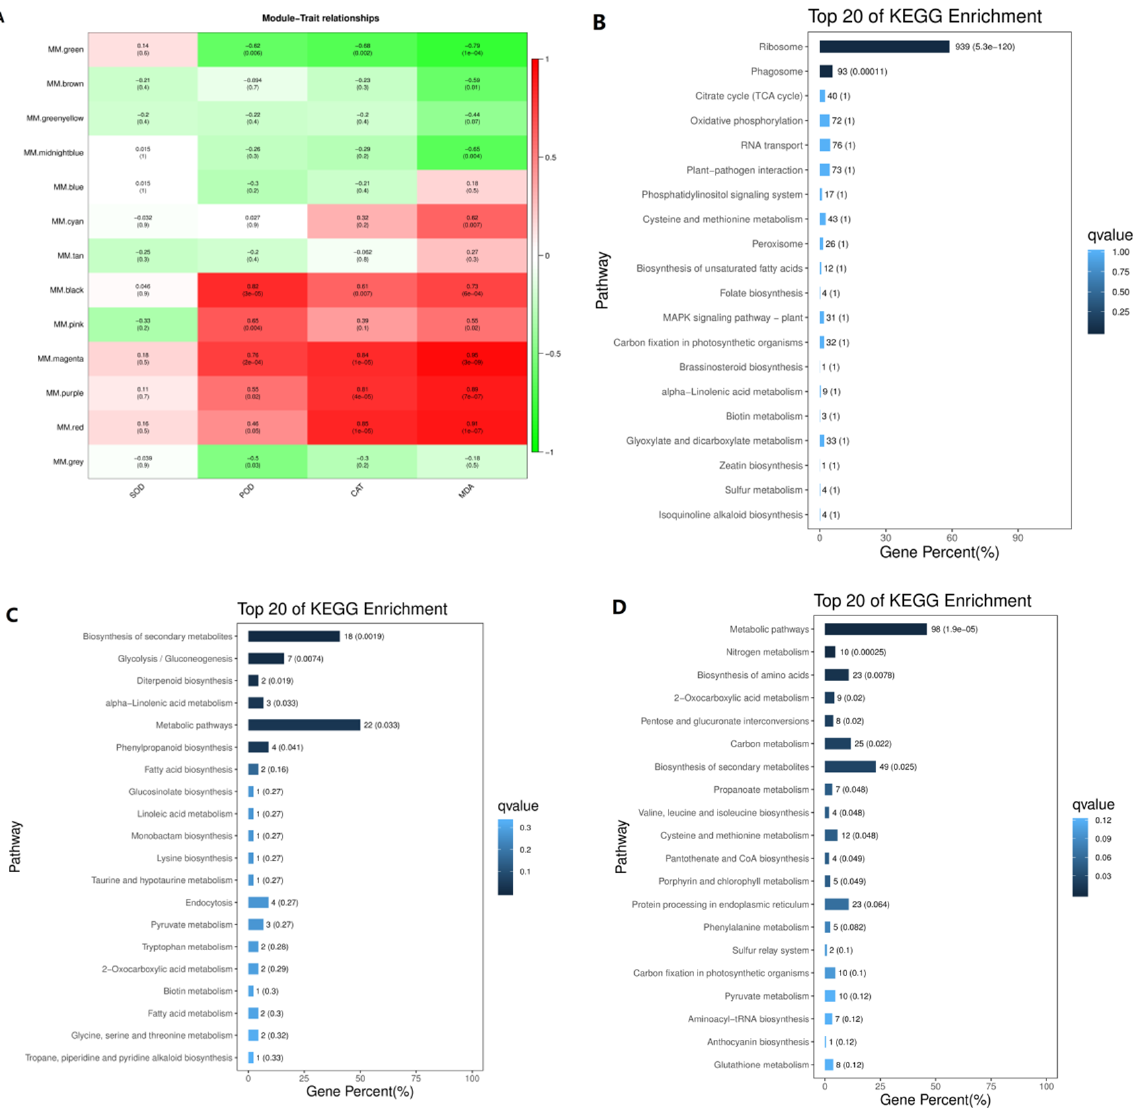
Figure 6. Co-expression network and KEGG enrichment pathways in goldenrain tree under cadmium stress. ( A ) Module- trait association. In the correlation matrix, each row corresponds to a module, and each column corresponds to one trait. The color of a cell at a row–column intersection indicates the correlation coefficient between the module and the trait. A high degree of correlation between a specific module and a trait is indicated by dark red (positive) or dark green (negative). ( B ) Top 20 KEGG enrichment pathways in the blue module. ( C ) Top 20 KEGG enrichment pathways in the magenta module. ( D ) Top 20 KEGG enrichment pathways in the red module.